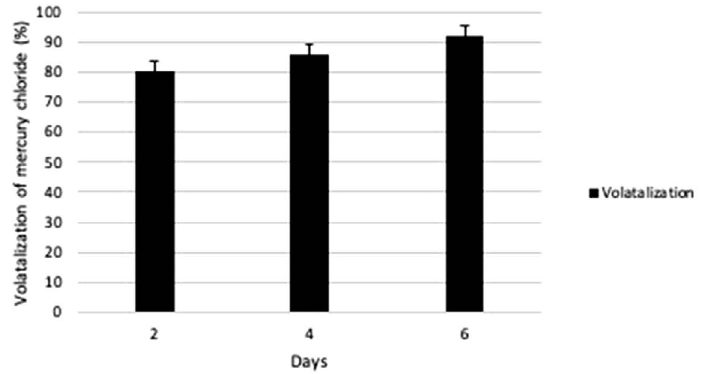
in soil (Panipat) 2